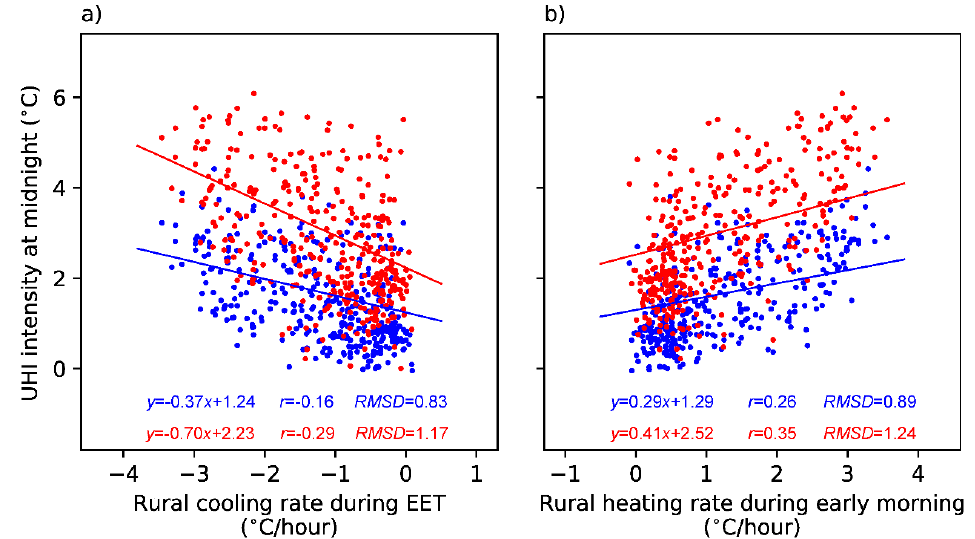
Figure 7. ( a ) Correlations between UHI intensity (°C) and mean rural cooling rate during early evening transition (EET) (°C /hour). Red and blue dots indicate urban and suburban sites, respectively. ( b ) Correlations between UHI intensity and mean rural heating rate during early morning.